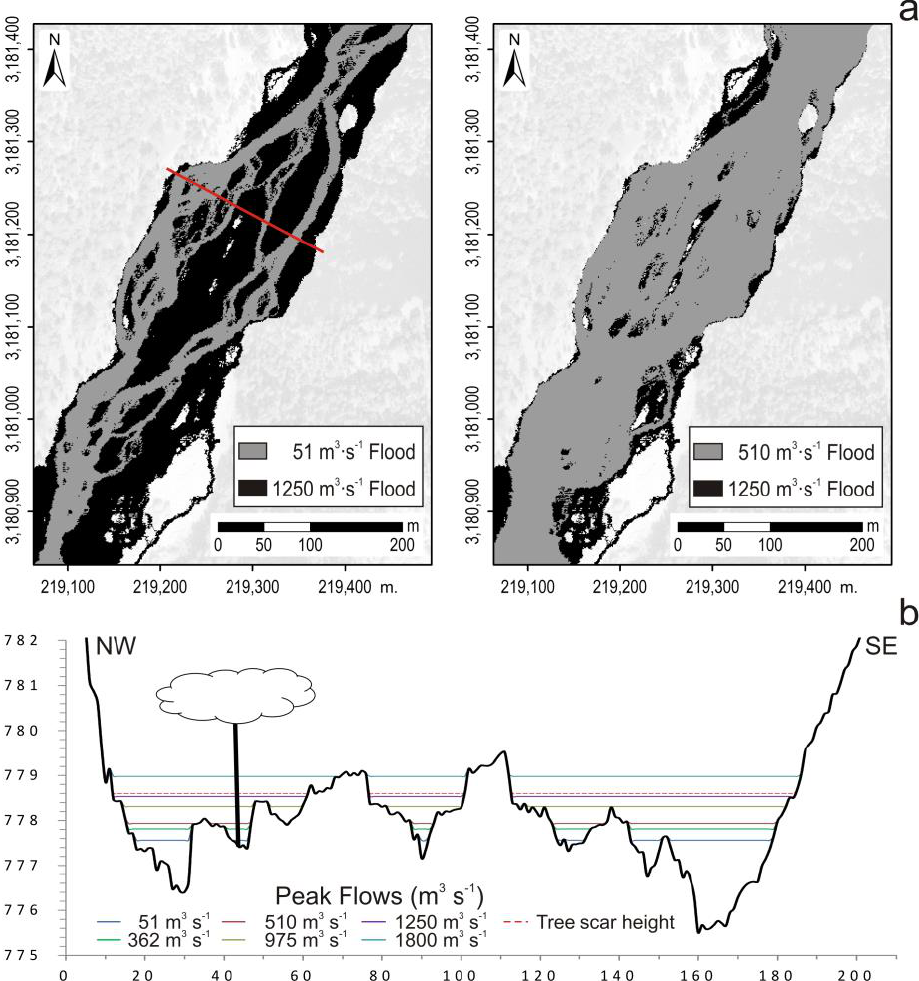
Figure 7. Flood prone areas for 51 m 3 s − 1 , 510 m 3 s − 1 , and 1250 m 3 s − 1 peak flow from two-dimensional (2D) hydraulic modeling ( a ). Solid red line shows location of channel cross-section. Channel cross-section shows flow depths for different peak flows using Manning´s formula ( b ).